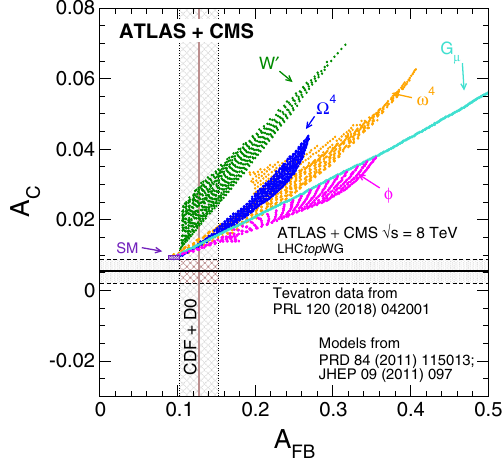
Fig. 2 Measurements of A C and A FB , compared to the SM prediction and predictions from simple new physics models. From ref. [32] The search for indirect new physics effects in the produc- tion and decay properties of the top quark continues at the LHC. Overall, the measurements agree with the SM,